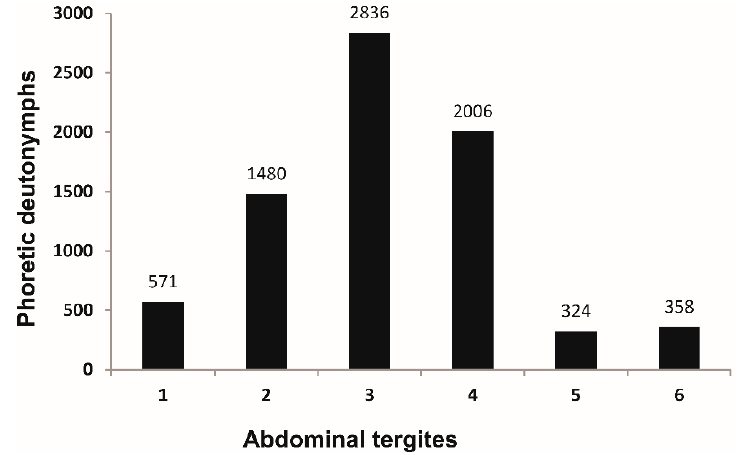
Figure 6. Number of phoretic deutonymphs of Trichouropoda sociata attached to the abdominal tergites of Plagionotus detritus .